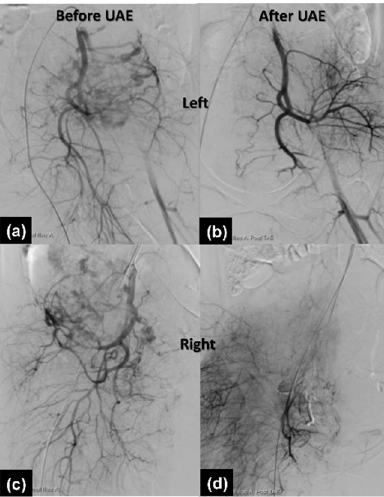
Figure 2. ( a ) Cord fixed at uterus (Case 1). ( b ) and ( c ) Repaired the uterus with interrupted sutures to approximate the uterine walls (Case 2).